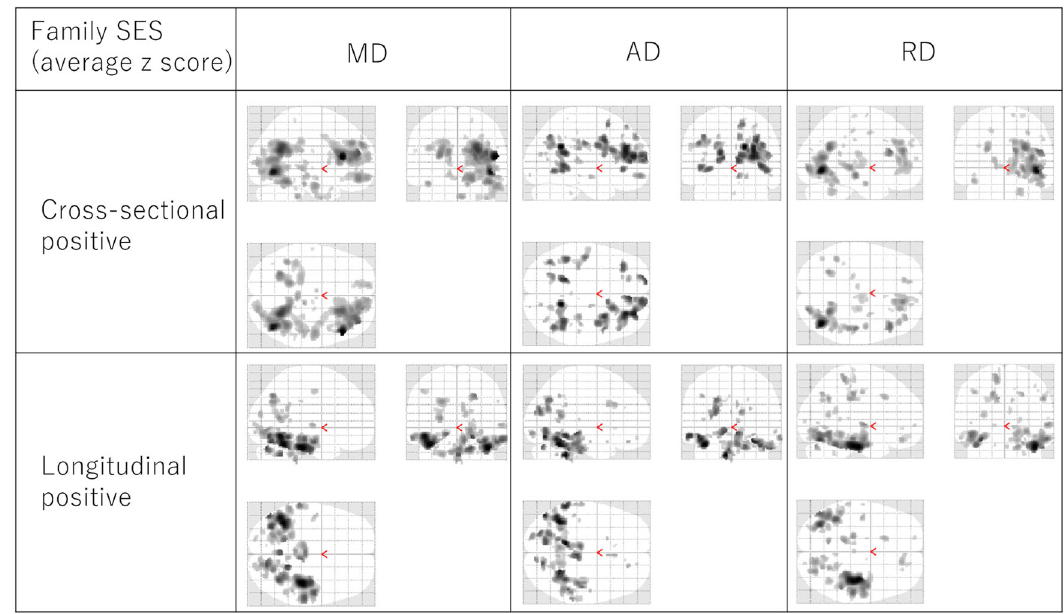
Fig. 7 Associations between childhood SES and brain structures. The fi gures in the left, middle, and right columns represent the average z-scores for associations between family income and parents ’ education with MD (left), AD (middle), and RD (right), respectively. The fi gures in the upper, middle, and lower rows represent positive childhood SES associations with diffusivity measurements in cross-sectional analyses (upper, N = 253) and longitudinal analyses (lower, N = 200). The results shown were obtained using an uncorrected threshold of p < 0.005. Associated regions are superimposed on a glass brain image from SPM. Similar associations were obtained by analysis of MD, AD, and